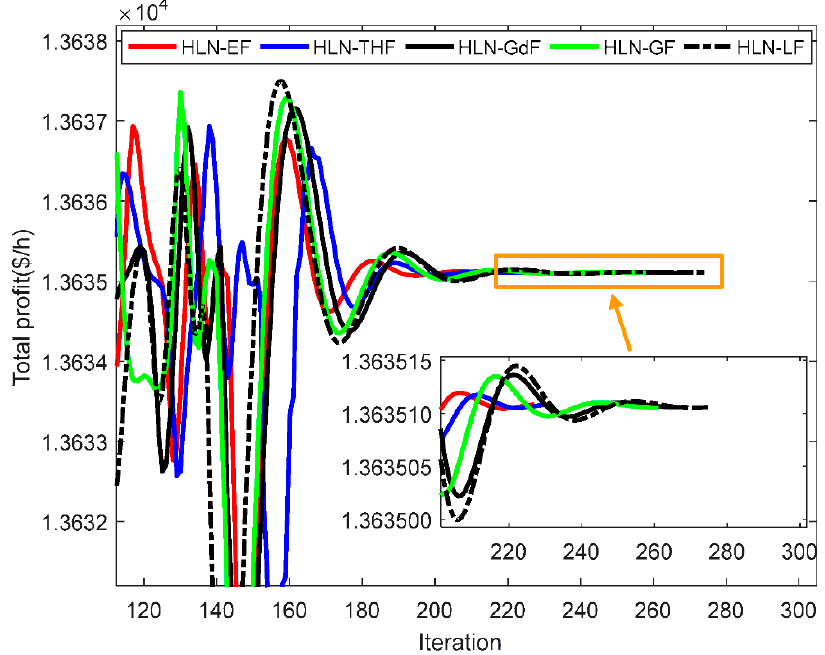
Figure 15. Zoom-in of Figure 14 from iteration 115 to the last iteration.